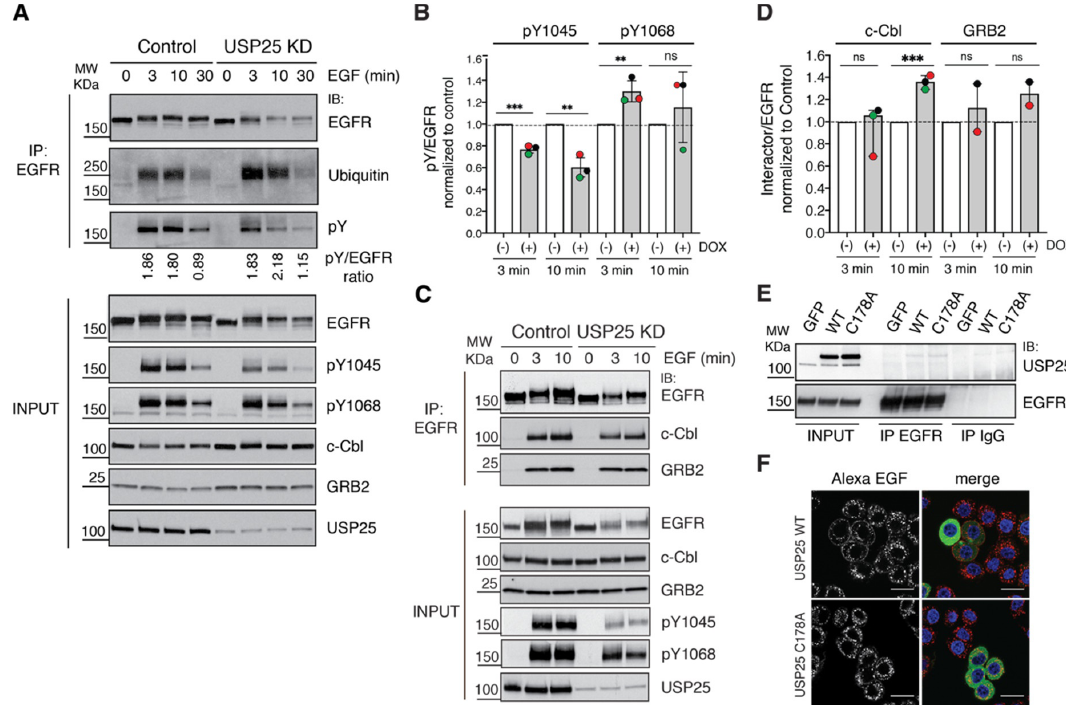
Figure 5. Altered phosphorylation and c-Cbl-EGFR interaction upon USP25 depletion. ( A ) Biochemical analysis of HeLa cells stably transfected with a shRNA targeting USP25 (USP25 KD) and control cells. USP25 depletion was induced with doxycycline treatment (0.5 µ g / mL). Serum-starved cells were stimulated with EGF (100 ng / mL) and total cell lysates were prepared. A total of 500 µ g of cell lysates